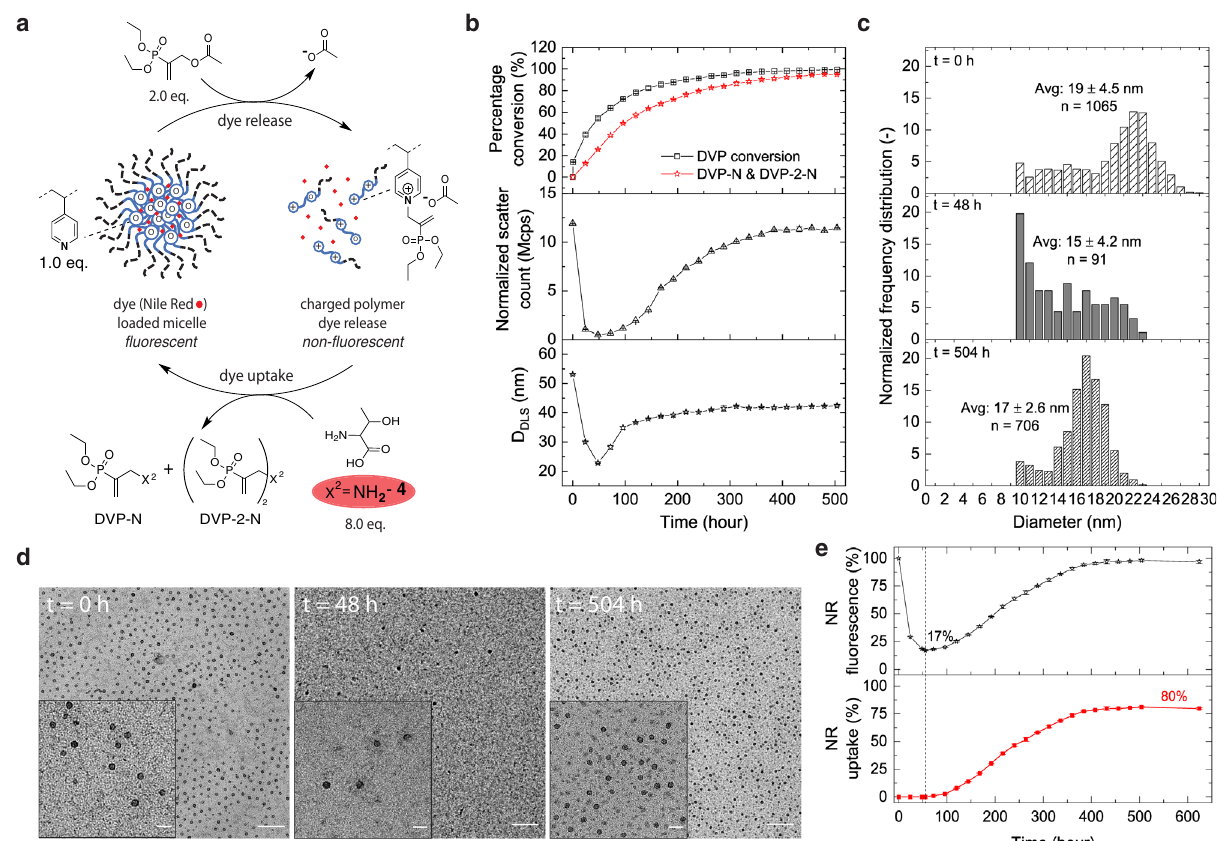
Fig.4|Fuel-drivenout-of-equilibriummicellar(dis)assemblyreactionnetwork in the absence and presence of Nile Red (NR). a Micellar dispersions (2.2mg/mL P1)werefuelledwithDVP(8.0mM,2.0eq.)andNH 2 - 4 (8.0eq.)in1.0mLphosphate buffer(0.5M,pH=7.4and10%D 2 O)(SupplementaryFig.12).Micellardispersionin ( e ) contained 15.5±0.1 µ g NR/mg of polymer (encapsulation ef fi ciency of 39%), while micellar dispersions in ( b ), ( c ) and ( d ) were without NR. b Stack graph (top) DVP conversion and DVP-N & DVP-2-N formation observed by 1 H NMR. (middle) Corresponding DLS measured normalized scatter count (Mcps). (bottom) Corre- sponding DLS measured Z-averaged diameter (D DLS in nm). c Normalized